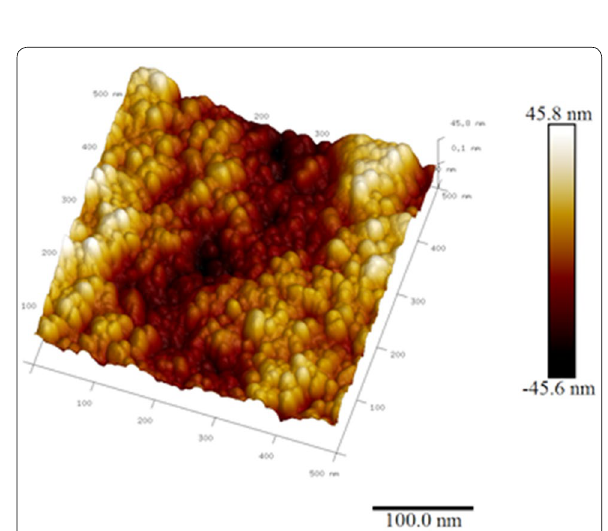
Fig. 4 Three‑dimensional AFM topographic images of TiO 2 film three layers coated on the FTO